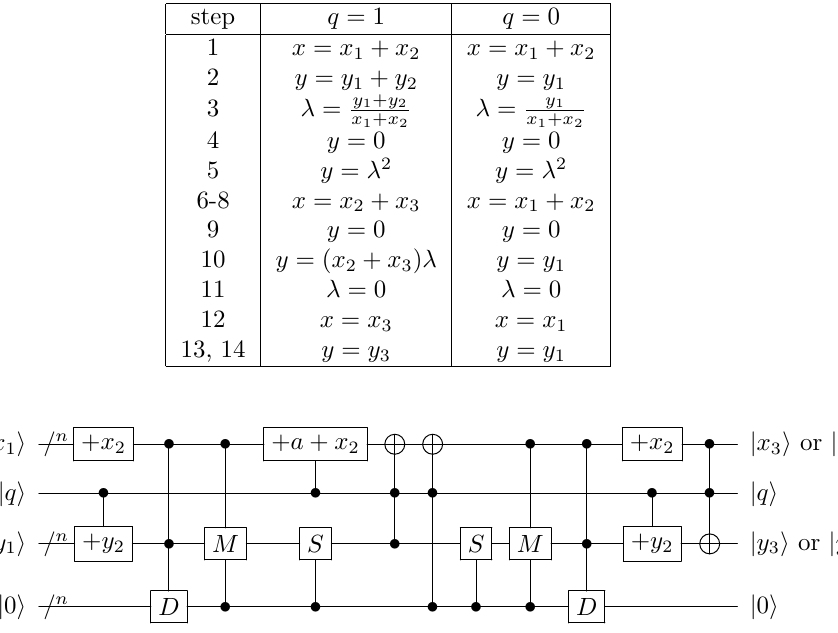
Circuit 7: Algorithm 3. M is MODMULT, S is squaring with separate output, D is